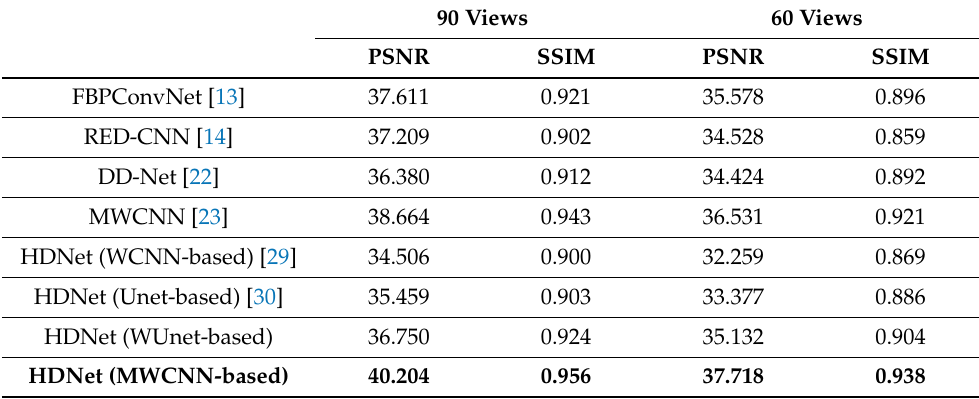
Table 2. Average PSNR and SSIM results for various deep learning reconstruction methods. 90